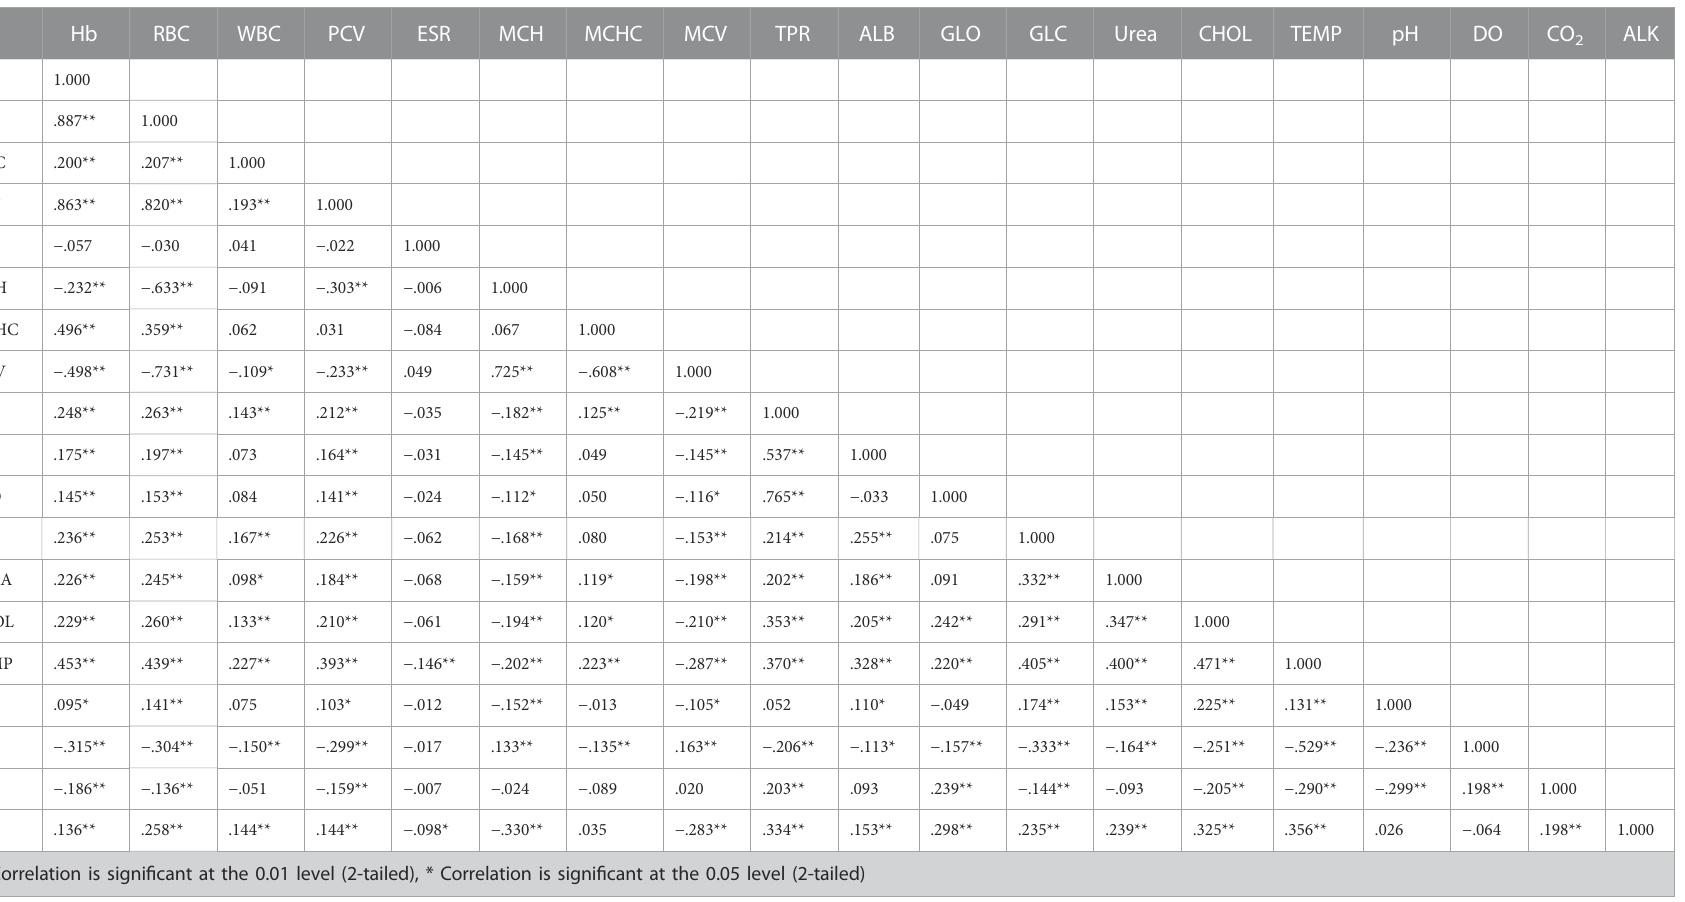
GLC .236** .253** UREA CHOL